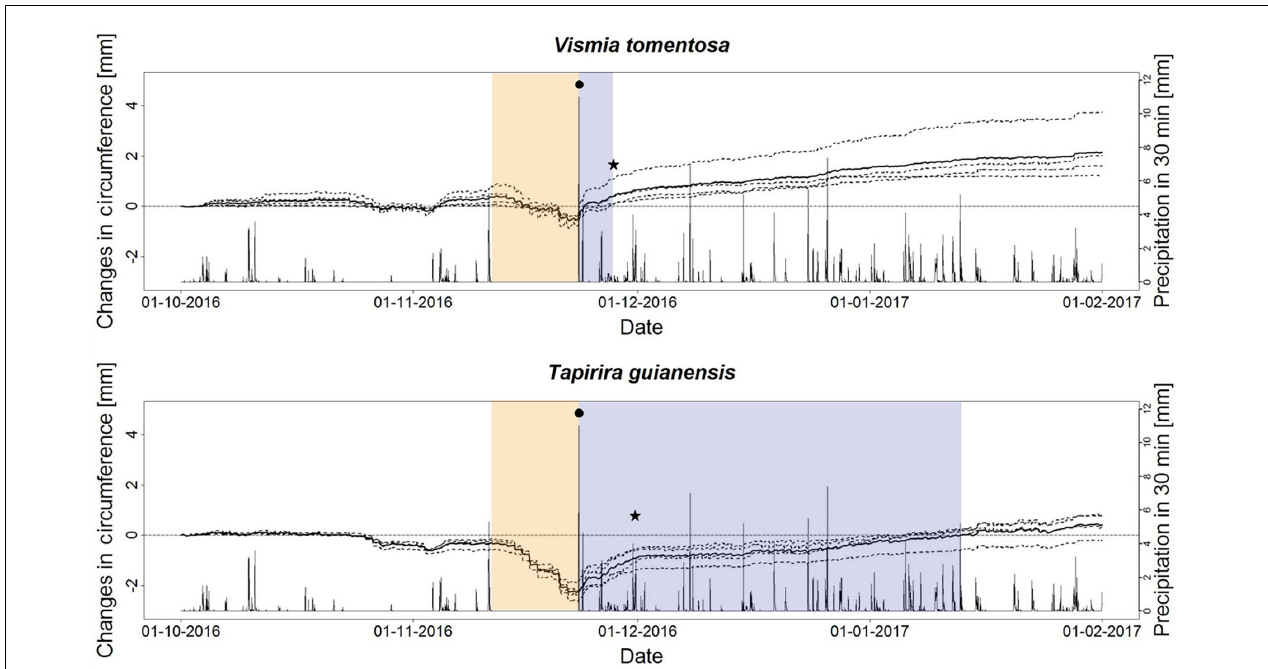
FIGURE 4 | Circumference change from October 2016 to February 2017 of Vismia cavanillesiana and Tapirira guianensis . Dotted lines show individual trees; solid lines show the corresponding mean values; orange backgrounds indicate the dry spell; blue backgrounds mark the time to reach the pre-drought maximum;